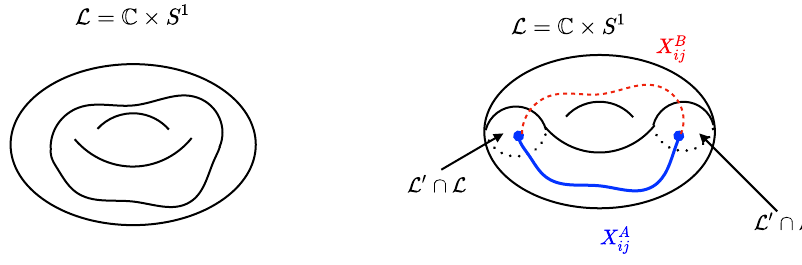
Figure 7 . On the left, we show a closed string loop X ( σ ) inside the non- compact Lagrangian manifold L = C × S 1 where we put probe D branes. On the right L is split into subregions by the entanglement branes on L 0 . The factorization map embeds the closed string X ( σ ) into open string configuration X A ( σ ) , X B ( σ ) which are glued together along the entanglement ij ij